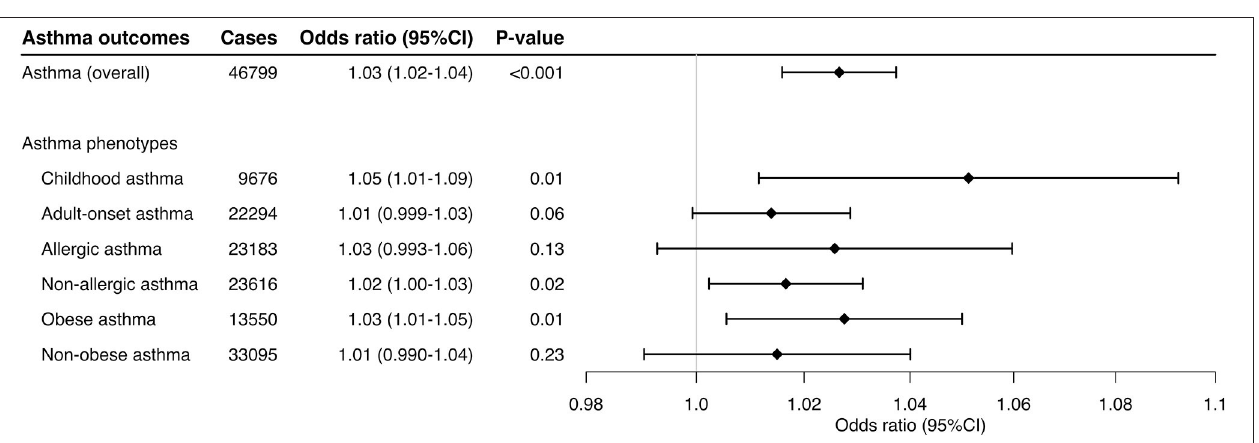
FIGURE 3 | Mendelian randomization estimates for the effect of soluble interleukin-6 receptors on asthma and its phenotypes using different thresholds. This sensitivity analysis used 16 variants selected with the use of more-stringent P GWAS (P GWAS < 5 × 10 − 8 ) and linkage disequilibrium ( r 2 < 0.02) thresholds. By using the inverse variance weighted method, the combined causal effect of sIL-6R on the asthma (overall) outcome and six asthma phenotypes was estimated. The odds ratios were estimated per one standard deviation increment in the inverse-rank normalized sIL-6R level. CI, confidence